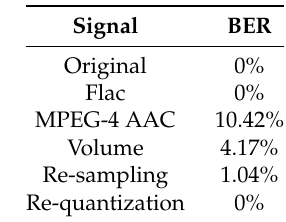
Table 6. Example of perceptual manipulations for original signal shown in Figure 4a: BER values of original signal versus modified signal.